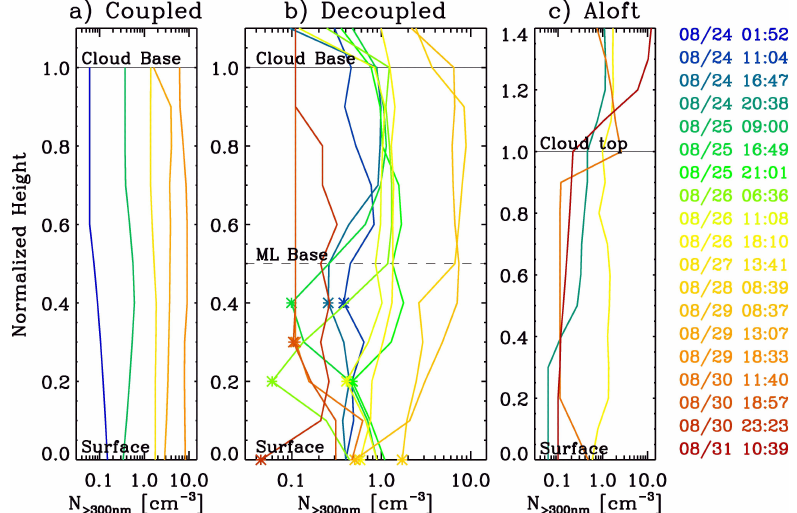
Fig. 16. Normalized vertical profiles of aerosol concentrations for particles larger than 300nm measured during all individual helicopter pro- files in the period of 24–31 August 2008. Profiles are distinguished by those that are (a) intermittently cloud–surface coupled, (b) decoupled, and (c) high altitude, reading above the nearby cloud top. Date and time stamps are color coded. Prior to normalization, profiles are created where the median aerosol concentration in 40-m vertical range bins is determined. Normalization in (a) and (b) is between surface (0.0) and cloud base (1.0), with the mixed-layer base (0.5) included in (b) . In (b) , the profile minimum below the mixed layer is designated by an asterisk. For (c) , normalization is from surface (0.0) to cloud top (1.0), and the “cloud top” height is from a cloud that occurs within two hours of the